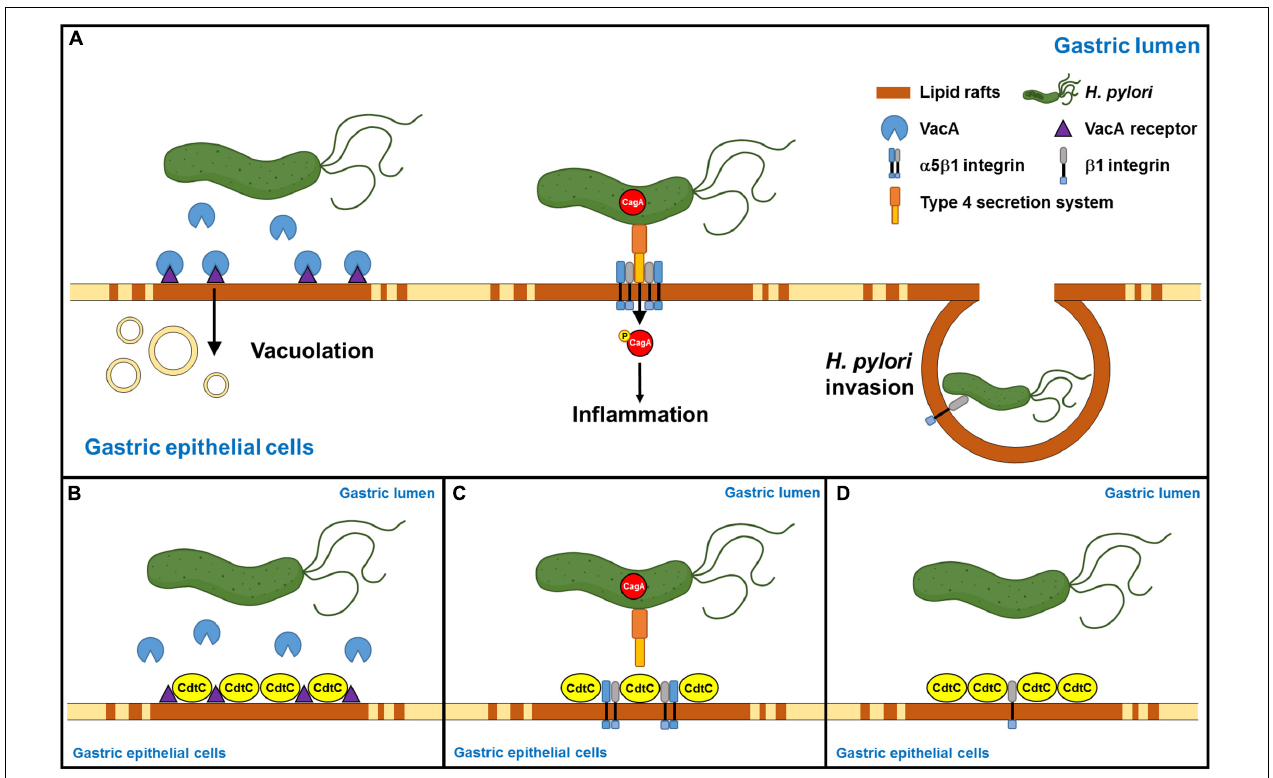
FIGURE 6 | Schematic representation of this study to summarize Campylobacter jejuni CdtC action and its potential application in the alleviation of Helicobacter pylori -induced pathogenesis. (A) H. pylori -secreted VacA binds its receptors in the lipid rafts, followed by inducing vacuolation formation in the cells. Furthermore, H. pylori directly injects CagA into the host cells through the interaction of TFSS and cellular α 5 β 1 integrin in the lipid rafts. Then, CagA is phosphorylated, which caused an inflammatory response. Subsequently, H. pylori invasion depends on H. pylori interacting with β 1 integrin. (B) C. jejuni CdtC inhibits VacA-induced cell vacuolation, (C) suppresses CagA translocation, and (D) declines H. pylori invasion in the gastric epithelial cells through the binding of lipid